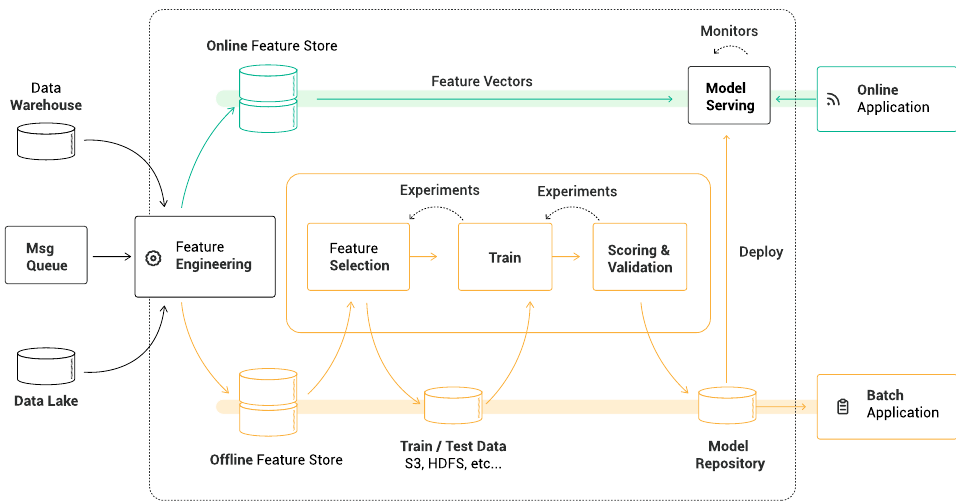
Figure 5. The Feature Store interface of Hopsworks and its core